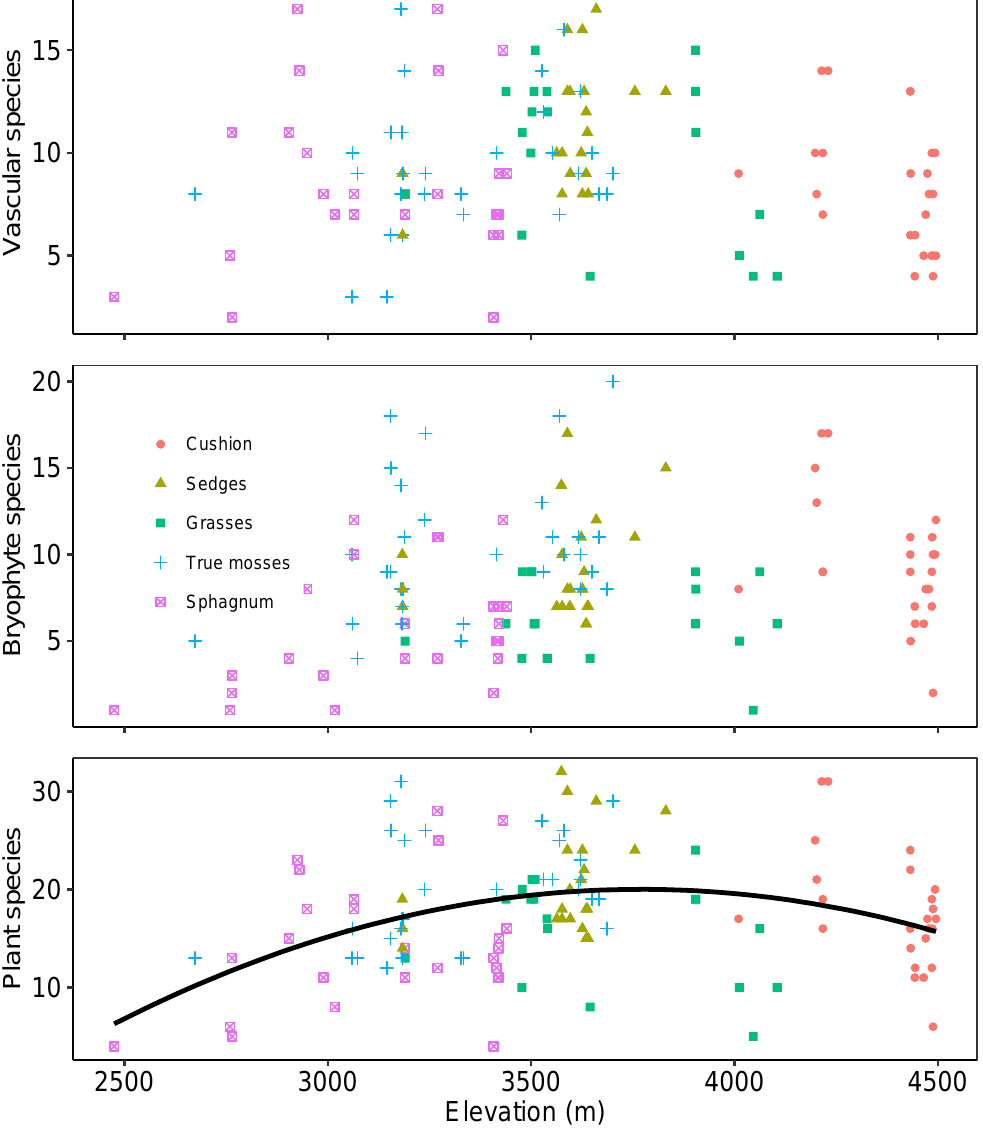
Figure 1. Variation between the number of species at each site and elevation for vascular plants ( top ), bryophytes ( center ) and all plants ( bottom ) differentiated by four different peat-forming vegetation types from 121 peatlands in the northern Andes. Our preliminary k-means cluster analysis indicated that classifying the sites into five groups provided the highest SSI. The five clusters corresponded with the dominance of different peat-forming plant species and had significant differences in their dispersion (PERMANOVA test F 3,117 = 11.2, p < 0.001, Table S2). The five clusters were named according to the dominant vegetation observed: (1) Sphagnum -dominated sites, (2) true mosses (Bryopsida), (3) grasses, (4) sedges, and (5) cushion plants (Figure 2). The number of plots ( n ) and total number of species or gamma diversity (S) for the different vegetation types are provided.